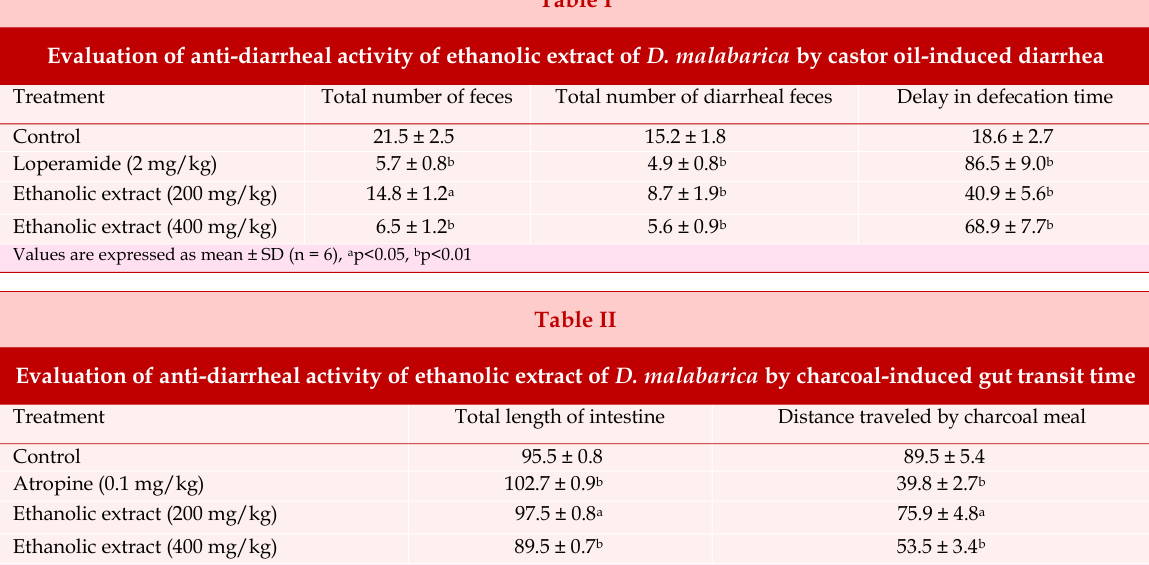
Values are expressed as mean ± SD (n = 6), a p<0.05, b p<0.01